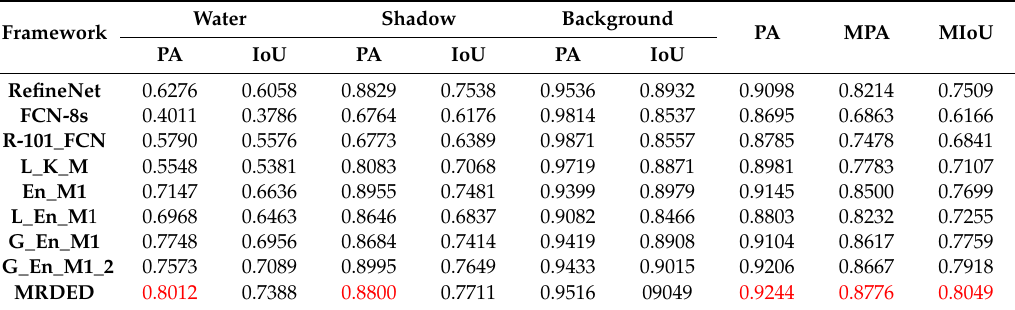
Figure 11b–d display the classification result by FCN-8s , ResNet-101_FCN , and Large_Kernel_Matters respectively from the SAR